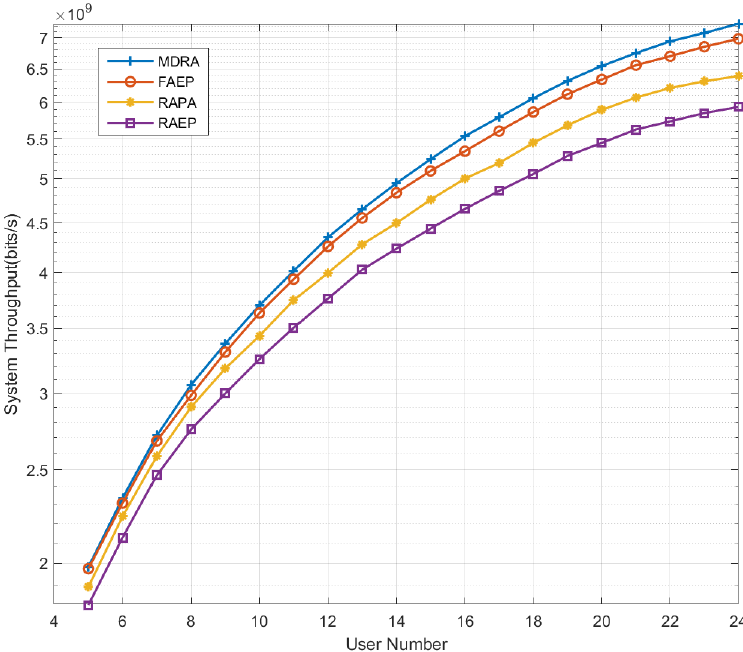
Figure 5. Comparisons of the system throughput, where N t = 16, N r = 64.